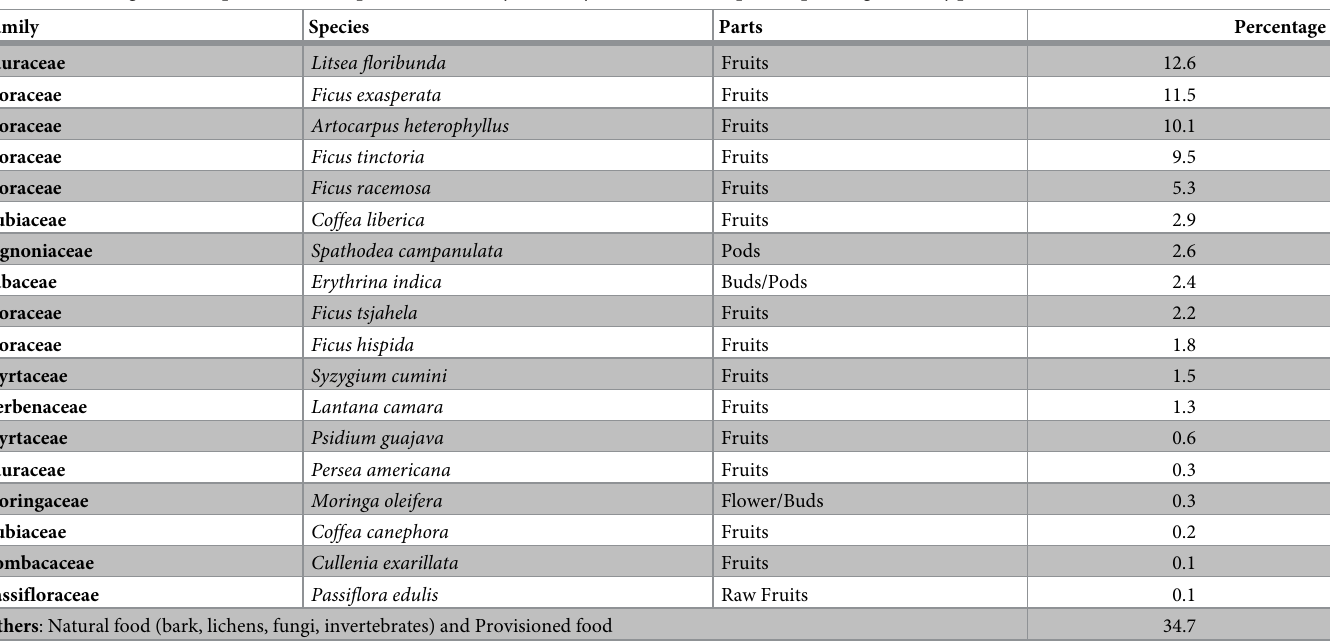
Table 2. Percentage of food species and their parts consumed by the study lion-tailed macaque troop during the study